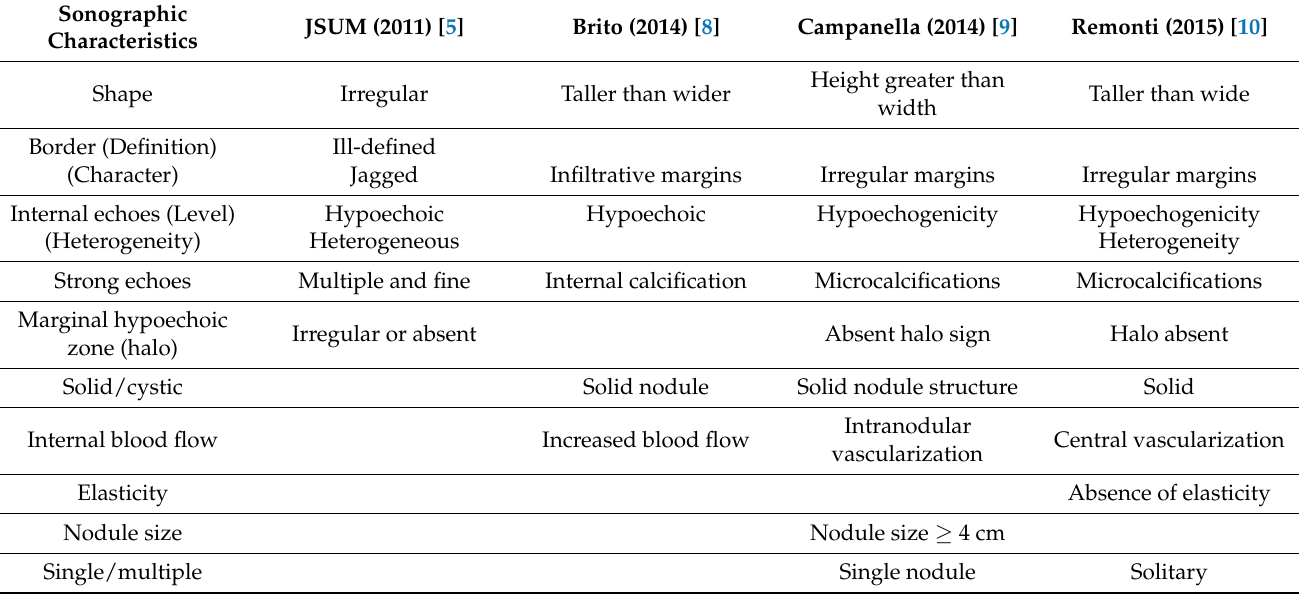
Table 1. Sonographic characteristics potentially suggesting